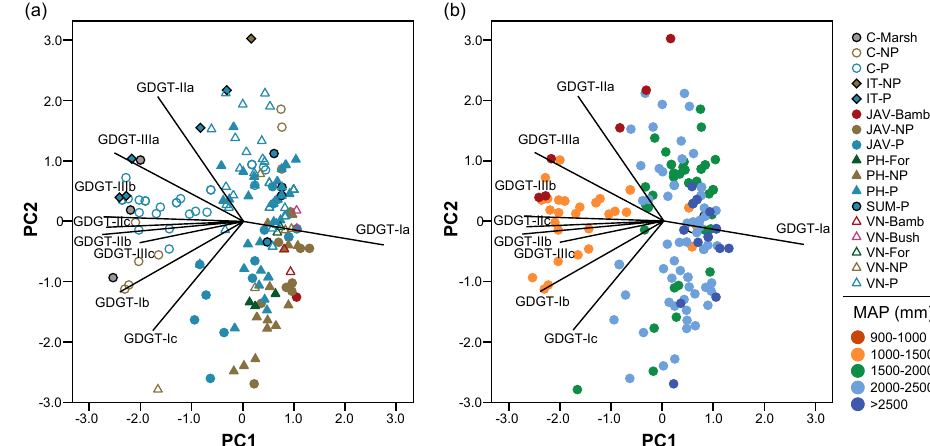
Figure 8. Principal component analysis (PCA) based on standardized relative abundances of nine brGDGTs in 170 investigated soils. The first principal component (PC1) accounts for 69.1% of the variance and the second (PC2) for 14.3%. Panel (a) : symbols and colours in upper legend denote different management forms. Abbreviations as in Fig. 2. Panel (b) : colours of the sample site symbols in lower legend are indicative of the mean annual precipitation.